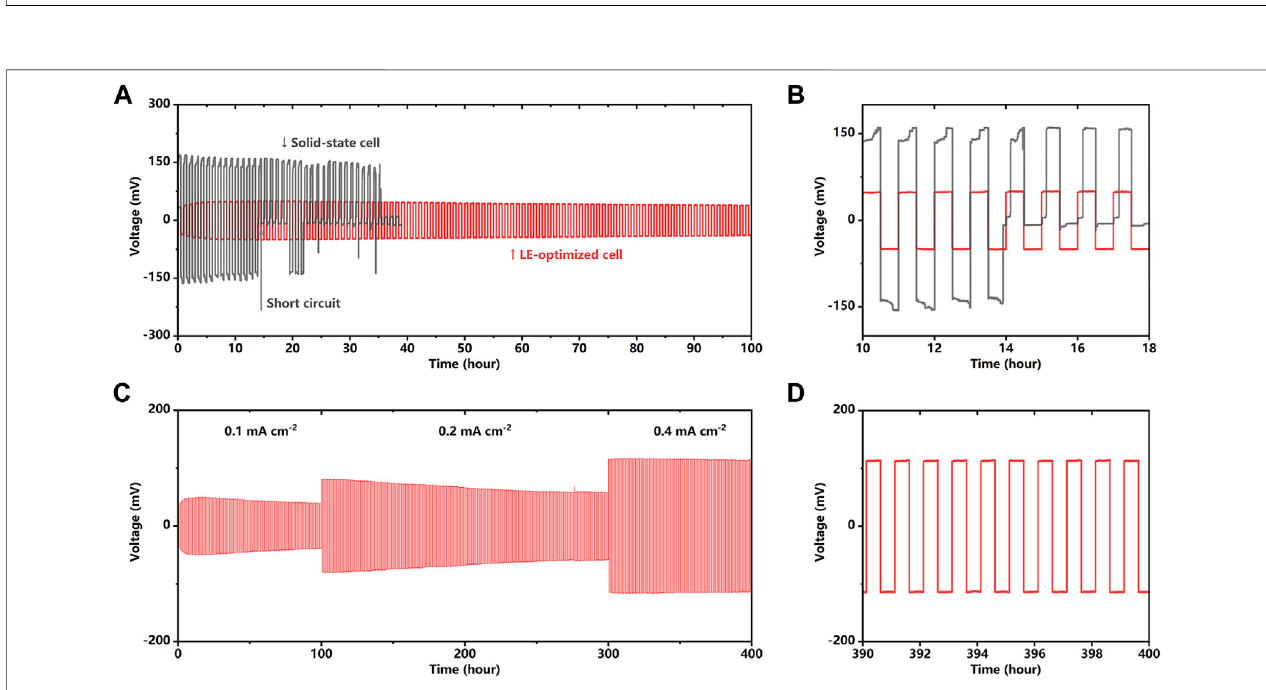
FIGURE 1 | X-ray diffraction (XRD) (A) , IR (B) , and Nyquist plots (C) patterns of the Li Arrhenius plots of the Li 2 OHCl and LE-soaked Li 2 OHCl from 45 ° C to 135 ° C.